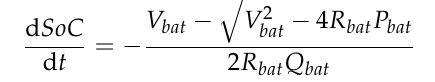
Figure 8. Characteristic curves of the battery.